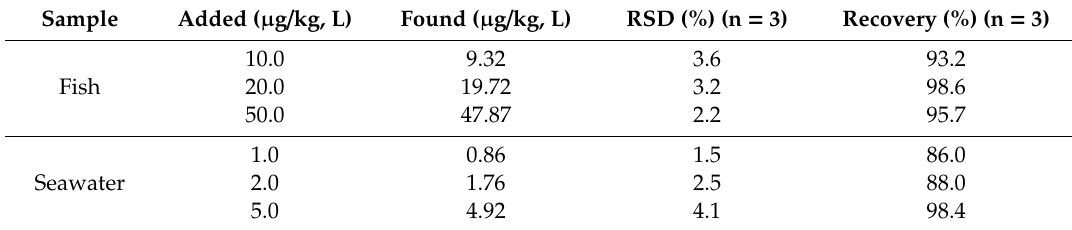
Table 1. Results of ECL measurements of CYF content in real samples using the proposed